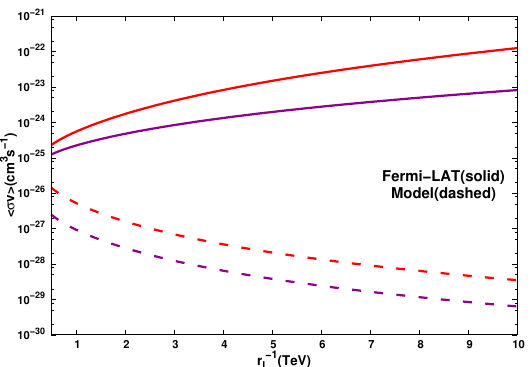
Figure 3 . Thermal-averaged cross sections (dashed lines) for B (0 ; 1) (cid:22) B (0 ; 1) (cid:22) ! W + W (cid:0) (blue) and B (0 ; 1)